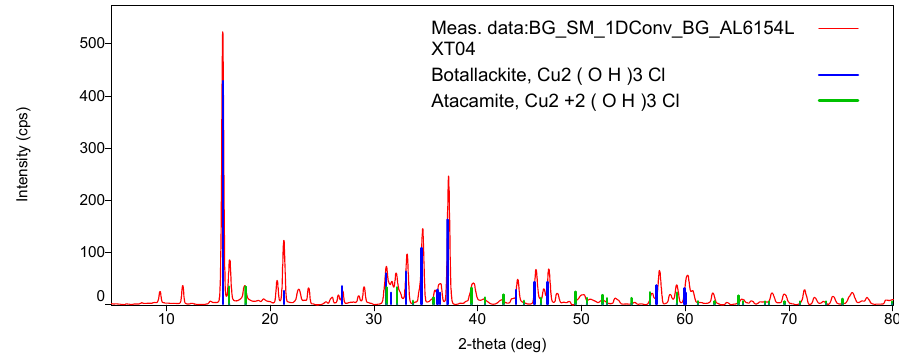
Figure 7. XRD patterns of LXT-04 and the references botallackite and atacamite.